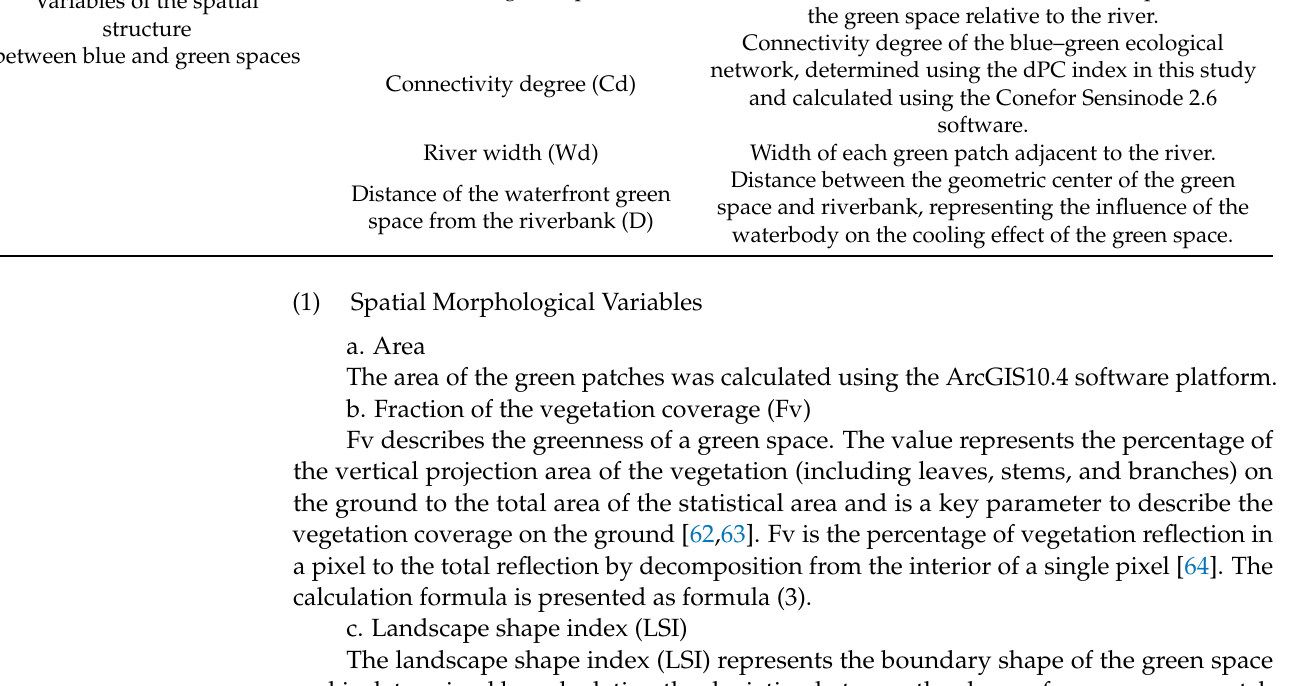
Table 1. Multi-dimensional spatial variables to describe the morphology of waterfront green spaces based on the cooling effect. Impact Variables Selected Index Definition and Description Area Surface area occupied by the green space in units (m 2 ). Variables of the spatial Fraction of the vegetation morphology coverage (Fv) of green spaces Indicates the complexity of shapes, determined by Landscape shape index (LSI) calculating the deviation between the shape of the green space patch and a square of the same area.